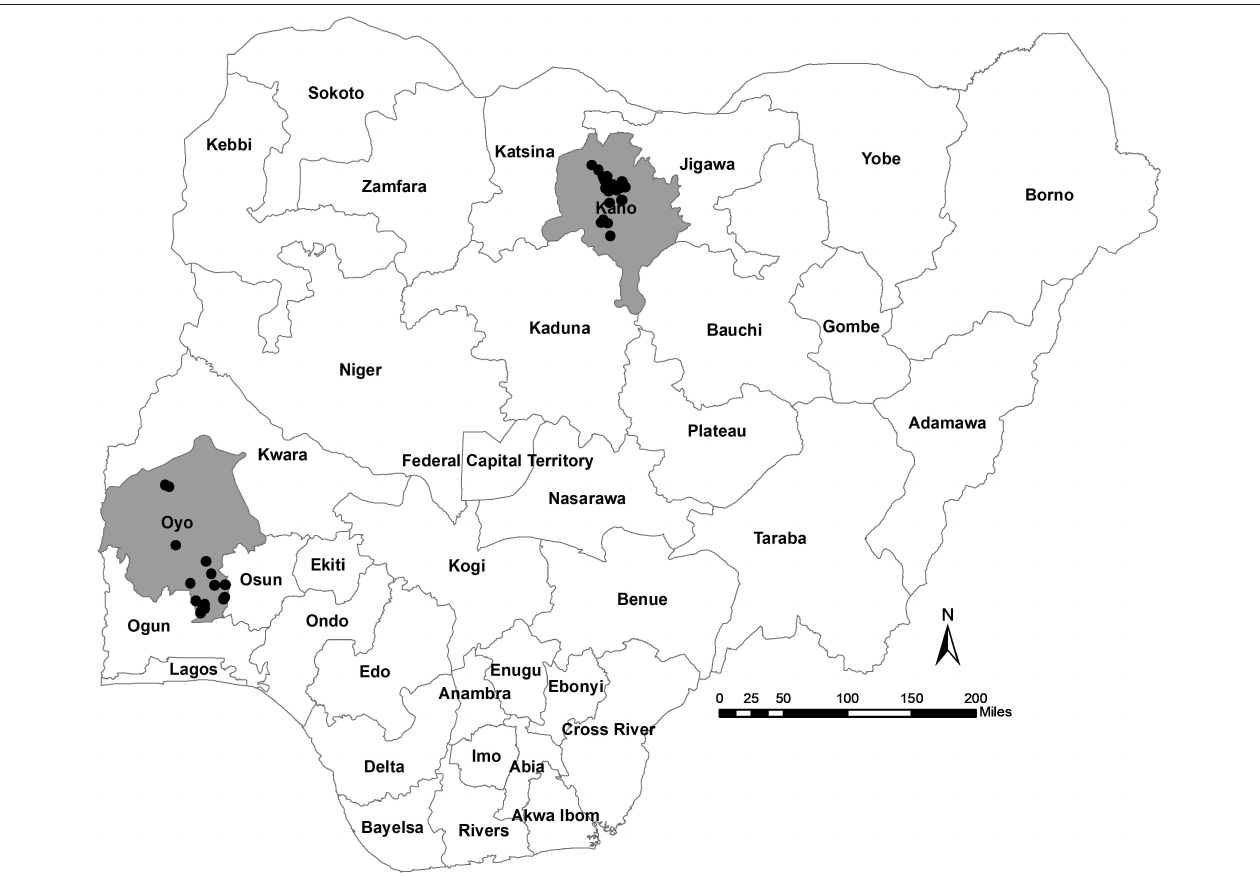
FIGURE 1 | Location of participating study farms (black circles) in Oyo and Kano States,